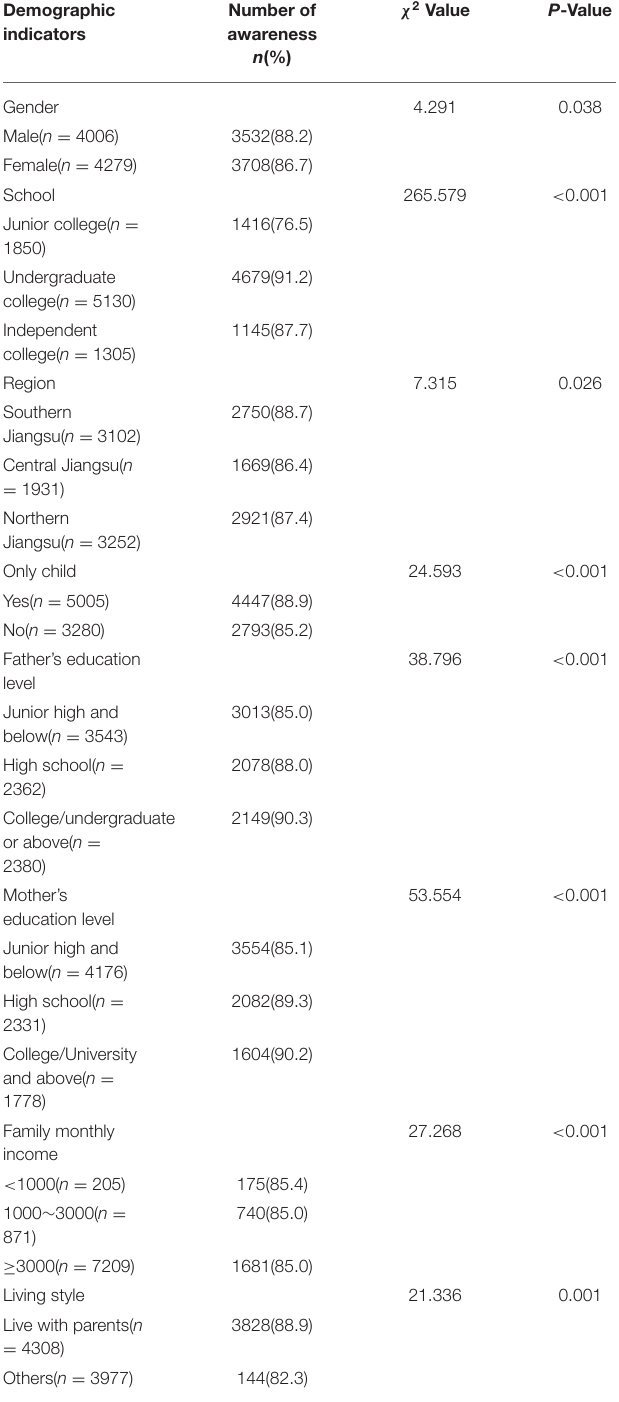
TABLE 1 | Single factor analysis of the overall awareness rate of AIDS knowledge among freshmen with different demographic